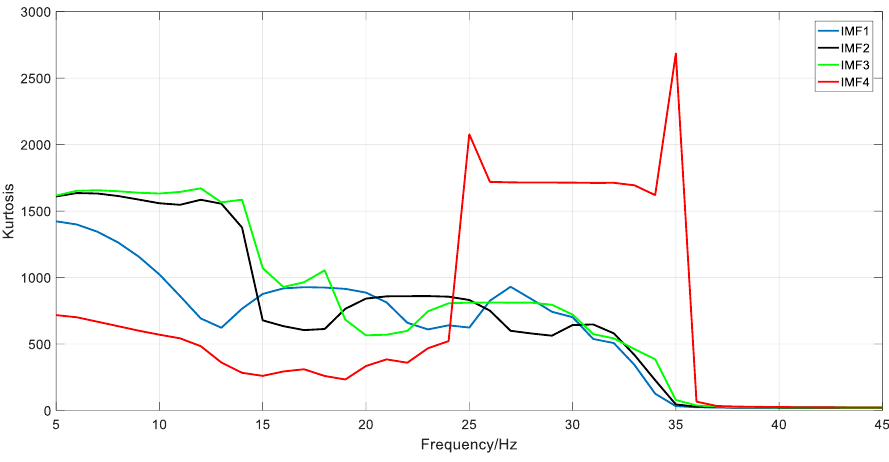
Figure 9. Results of the protrugram when the bandwidth (BW) = 10 Hz. Table 3. The calculated spectral kurtosis entropies.